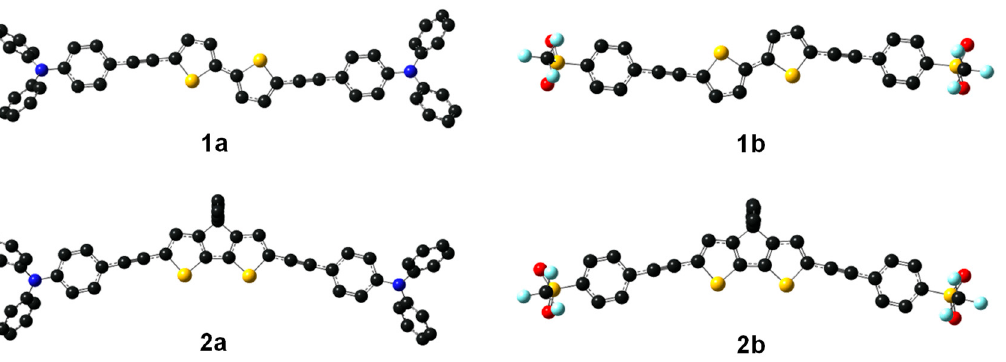
Figure 3. DFT PBE0/6-31 + G(d) optimized structures of the most stable GS conformers for molecules 1a , b and 2a , b in toluene.